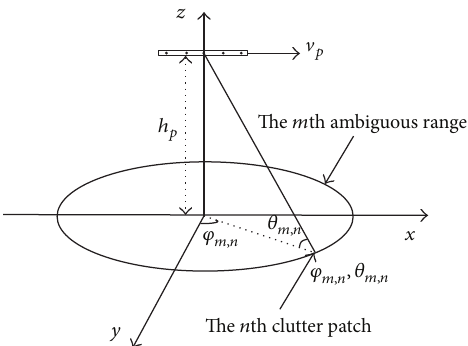
Figure 1: Airborne radar geometry with a ULA